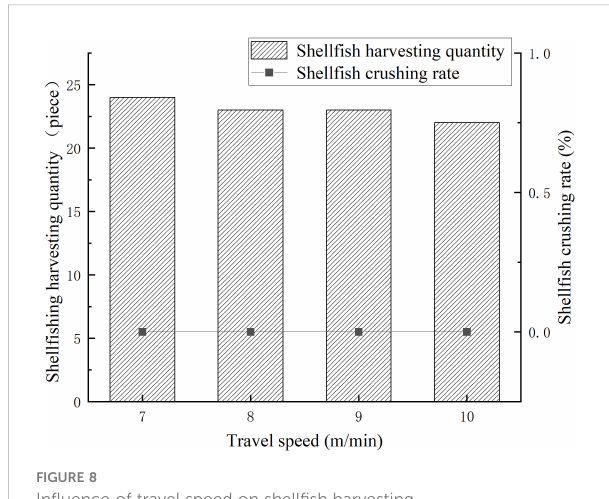
FIGURE 8 In fl uence of travel speed on shell fi sh